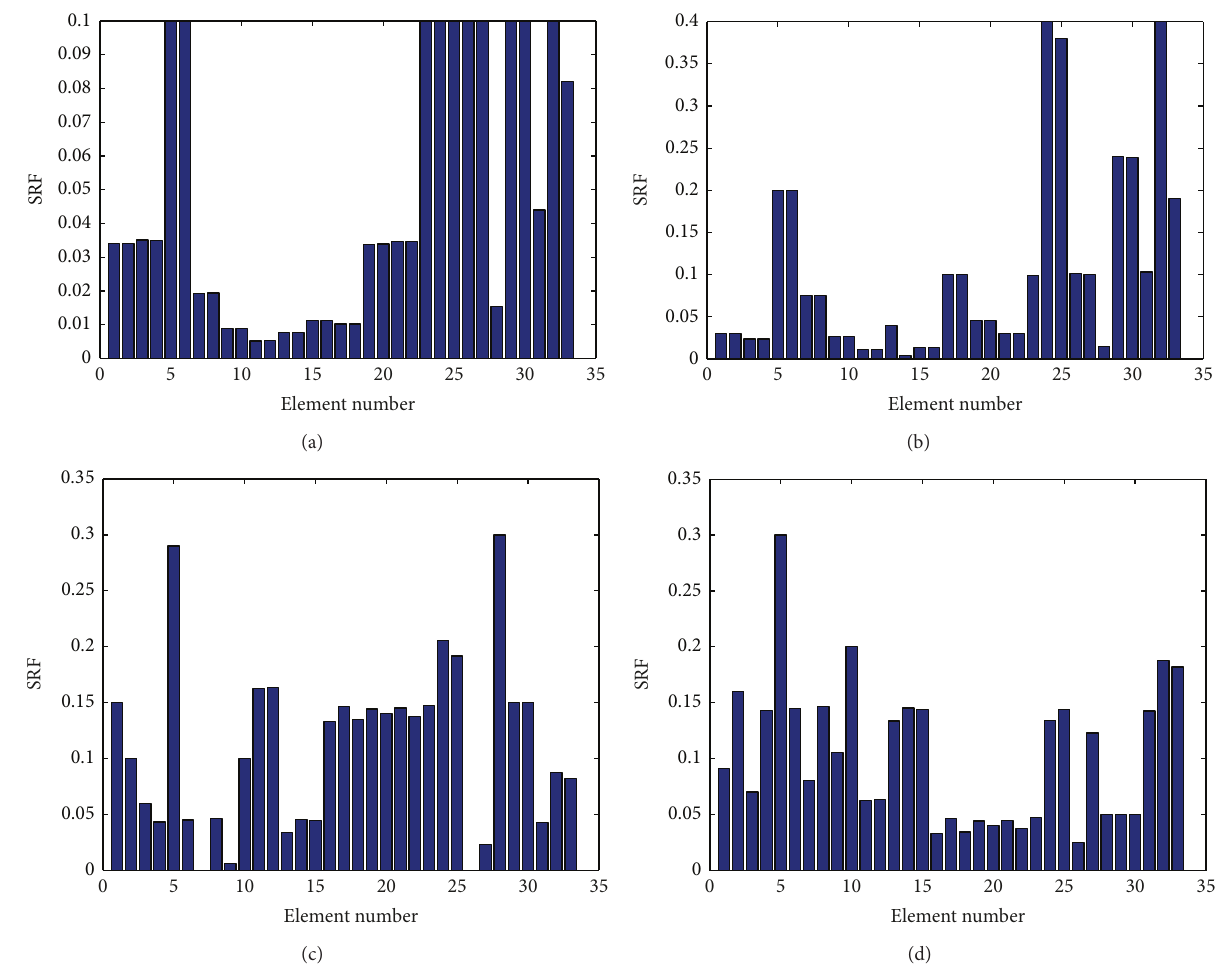
Figure 7: SRF values of global sensitivity method (iterations 1, 4, 9, and 10).